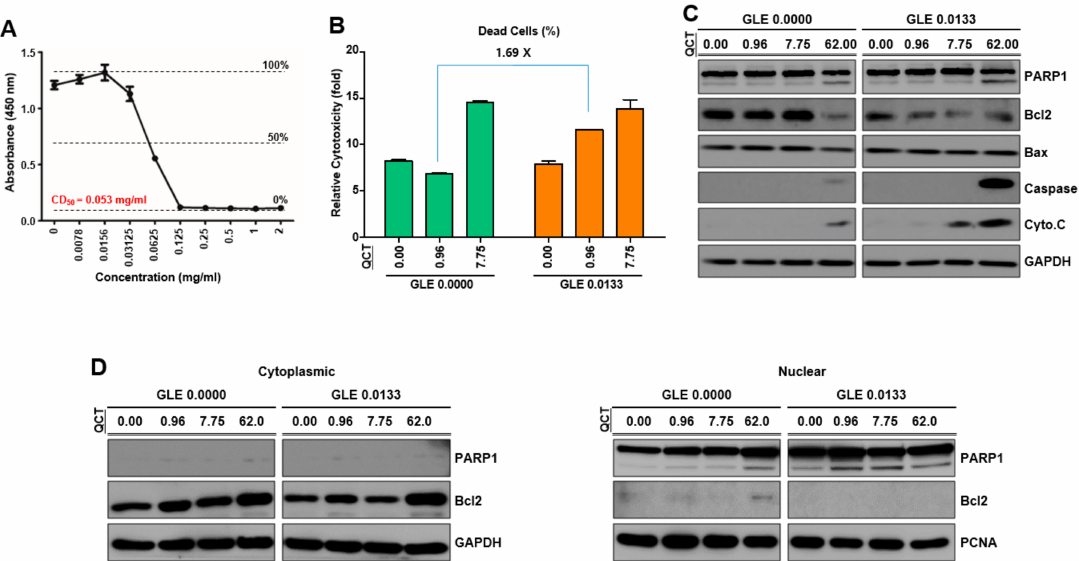
Figure 4. Cotreatment with GLE and QCT decreased cell viability and induced apoptosis. ( A ) Measurement of CD 50 of GLE in SNU719 cells. GLE CD 50 was 0.0532 mg / mL. ( B ) The determination of the cytotoxic e ff ects of cotreatment with 0.0133 mg / mL GLE and various concentrations of QCT in SNU719 cells. ( C ) A western blot analysis for the determination of the expression of apoptotic proteins in total proteins derived from SNU719 cells. ( D ) A western blot analysis for the determination of the expression of apoptotic proteins in cytoplasmic and nuclear fractions of SNU719 cells. GLE and QCT: Ganoderma lucidum extracts and quercetin,